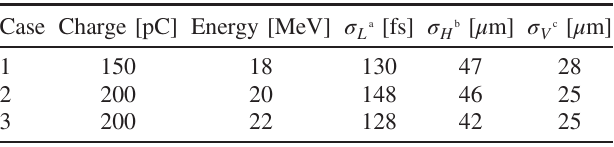
TABLE I. Performances of the